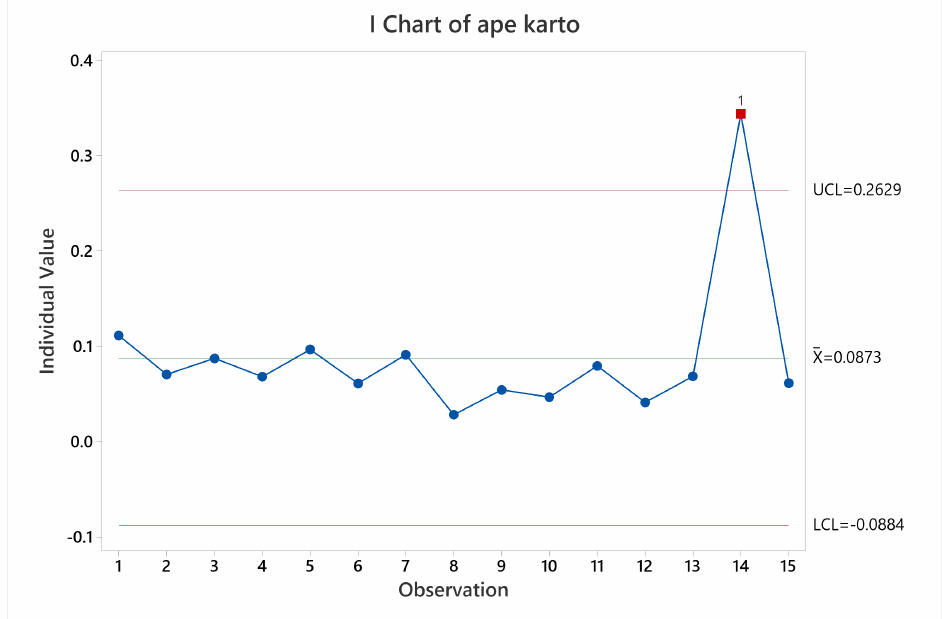
Figure 23. Pose accuracy mean behavior for KARTO-SLAM.